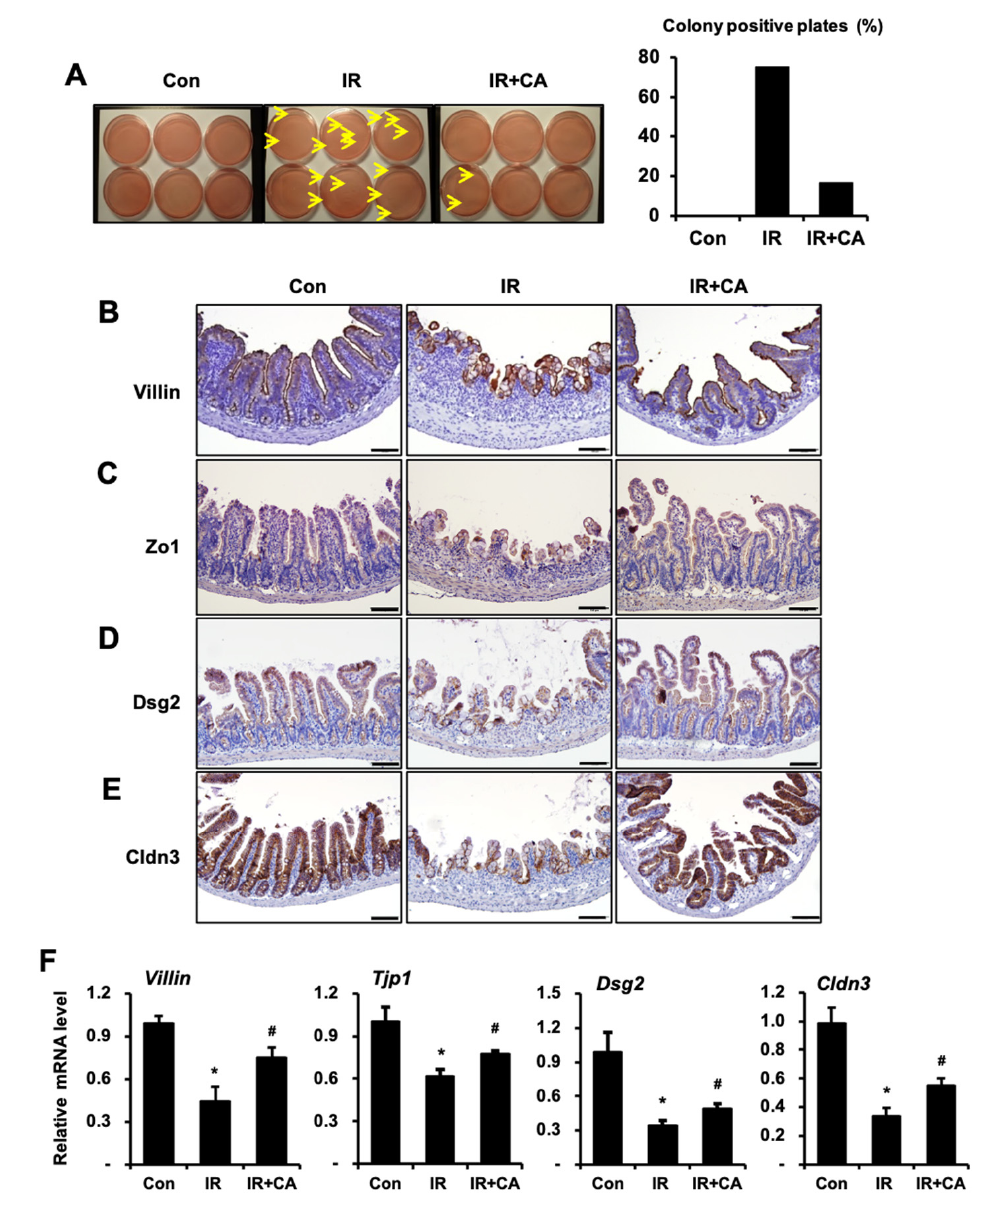
Figure 3. Centella asiatica ameliorates radiation-induced intestinal barrier dysfunction in vivo. ( A ) The bacterial colonies from mesenteric lymph node of control (Con), irradiated (IR), and Centella asiatica (CA)-treated IR group (IR + CA) were quantified. The graph is depicted as the percentage of individual mice exhibiting colonies in the group. n = 6 mice per group. ( B – E ) Representative images of small intestine stained with villin, zonula occludens 1 (Zo1), desmoglein 2 (Dsg2), and claudin 3 (Cldn3). ( F ) qRT-PCR analysis demonstrating the mRNA levels of Villin , Tjp1 , Dsg2 , and Cldn3 in small intestine of each group. Data are presented as the mean ± standard error of the mean; n = 6 mice per group. * p < 0.05 compared to the Con group; # p < 0.05 compared to the IR group. Scale bars represent 100 µ m. All data represent at least two independent experiments.